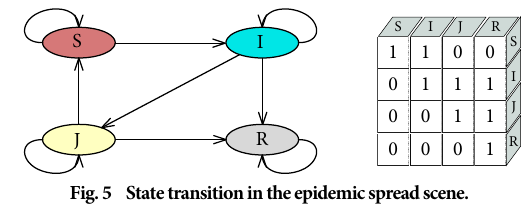
Fig. 5 State transition in the epidemic spread